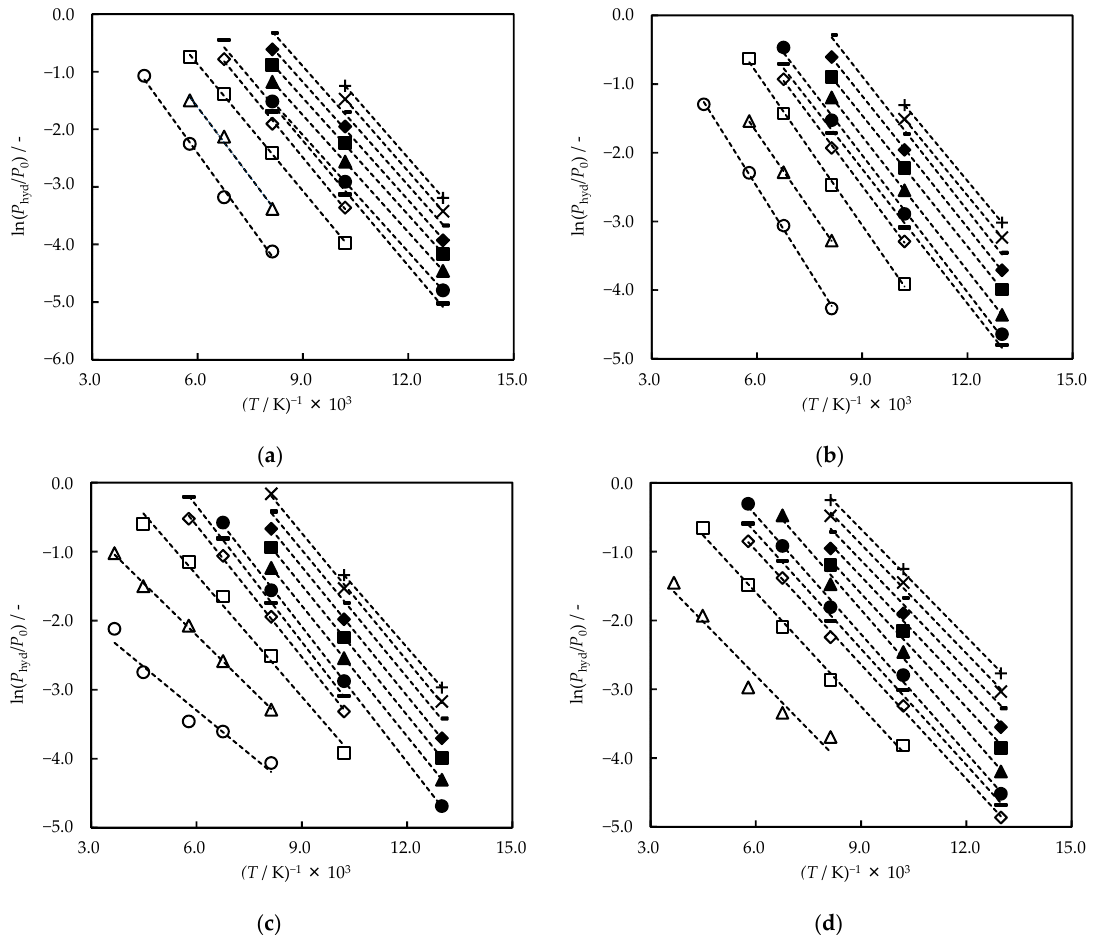
Figure 9. Van’t Hoff plots for ( a ) KB, ( b ) KB_0.6, ( c ) KB_4.9, and ( d ) KB_9.3. Hydrogen content/mass %, ○ : 0.05, △ : 0.1, □ : 0.2, ◇ : 0.3, ─ :0.35, ● : 0.4, ▲ : 0.5, ■ : 0.6, ◆ : 0.7, -: 0.8, ×: 0.9, +:1.0. Dotted lines show linear approximations.